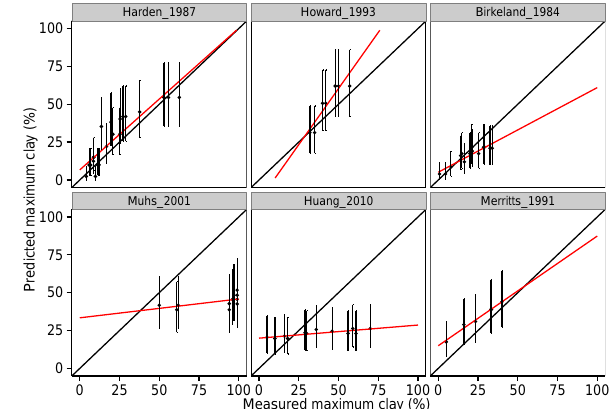
Figure 6. Selected relationships between the measured maximum clay content and predicted maximum clay content. (a) Harden (1987), (b) Howard et al. (1993), (c) Birkeland (1984), (d) Muhs (2001), (e) Huang et al. (2010), and (f) Merritts et al. (1991). The er- rors represent the conditional standard deviations around the mean, which correspond to a probability of 50%. The model effectively predicted clay content across a diverse range of climates, landforms, and parent materials. The model was the least effective at predict- ing the clay content of soils in tropical climates and soils forming on coral reef